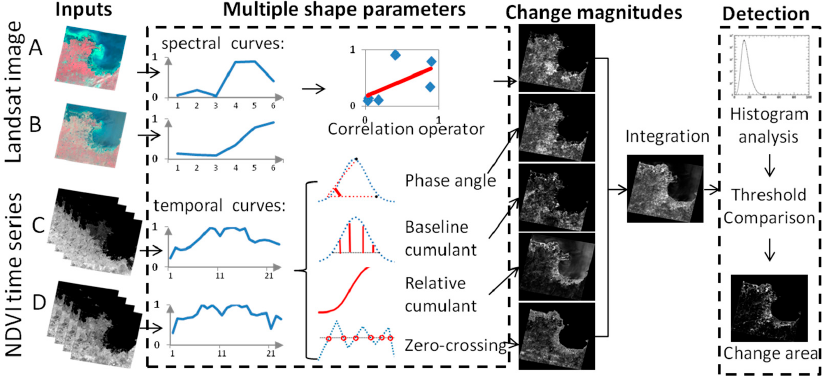
Figure 1. Integrating multiple shape parameters to detect land cover